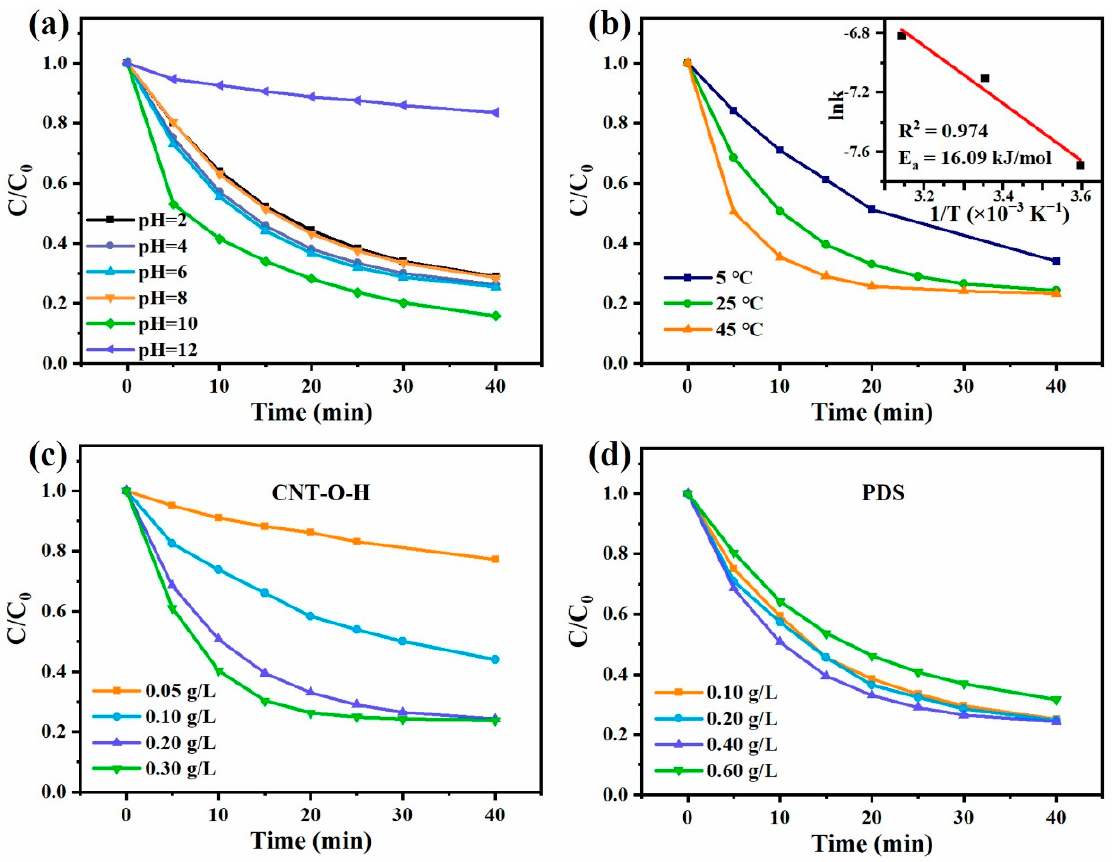
Figure 6. TC degradation under different initial pH ( a ), temperature ( b ), CNT-O-H dosage ( c ) and PDS dosage ( d ) (General conditions: 25 °C, natural pH, 0.2 g/L CNT-O-H, 0.4 g/L PDS, 50 mg/L TC).